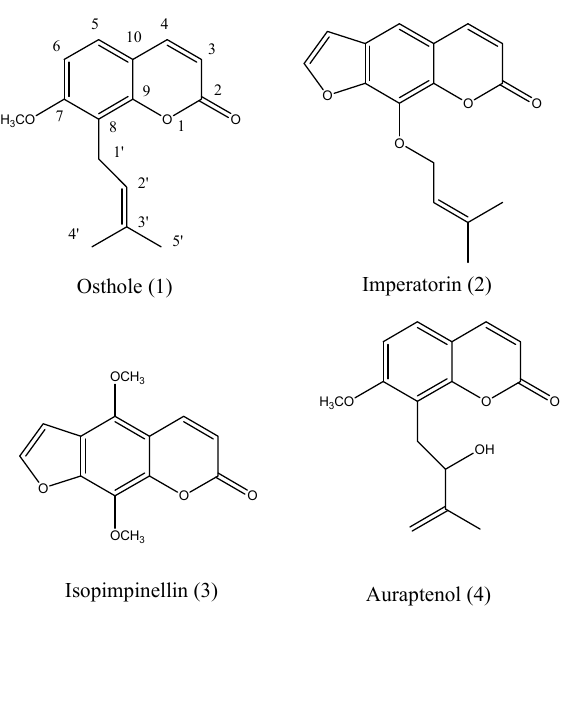
Figure 4. The chemical structures of Compounds 1 – 4